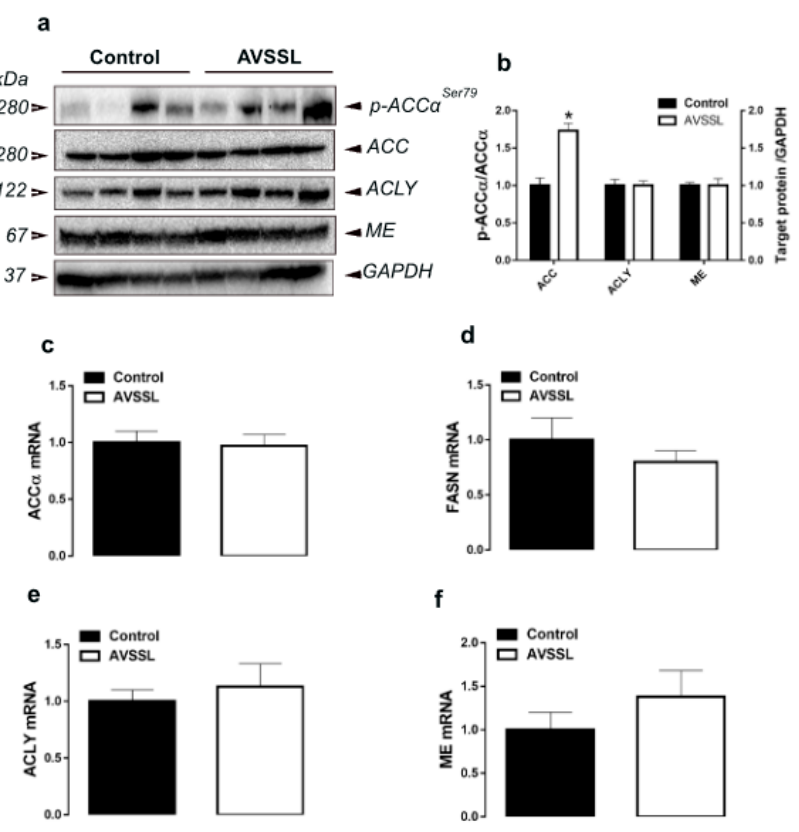
Figure 1. Effect of the phytogenic water additive AVSSL on the expression of lipogenesis-related proteins in liver tissue. Protein levels ( a , b ) were measured by Western blot and mRNA abundances ( c – f ) were determined by qPCR using the 2 − ∆∆ Ct method [21]. Data are presented as the mean ± SEM ( n = 8 birds/ group). * Denotes significant difference compared to the control group at p < 0.05. ACC α , phosphorylated-acetyl CoA carboxylase; ACLY, ATP citrate lyase; FASN, fatty acid synthase; ME, malic enzyme. Table 1. Effect of the phytogenic water additive AVSSL on lipid metabolism genes in the liver tissue a . Parameters